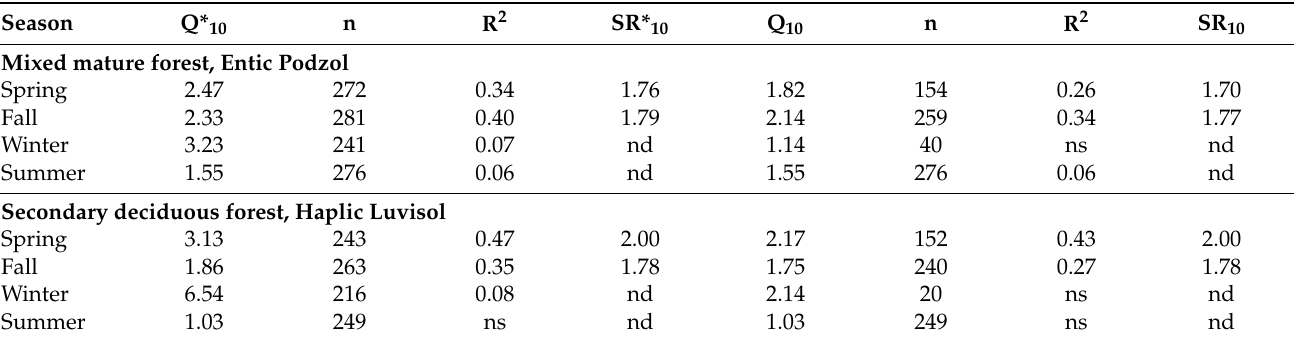
Table 3. Temperature coefficients (Q* 10 and Q 10 ) of soil respiration, SR* 10 , and SR 10 values for different calendar seasons in the two types of